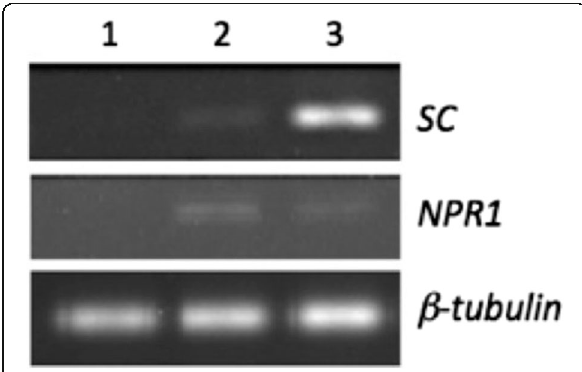
Fig. 3 NPR1 and Sesquiterpene cyclase genes induced in root inoculated plantlets of Capsicum annuum L . Genes level induction assessed by semi-quantitative RT-PCR. Assays with mixed total RNA from root and leaves of mirasol cultivar pepper plantlets in root inoculated with B. velezensis 2A-2B strain, at 12 hs post- inoculation. Lane 1, control plant not inoculated (mock); lane 2, plant in root inoculated with 2A-2B strain; lane 3, a B. velezensis strain inducer of SC gene in chili pepper. SC , sesquiterpene cyclase; NPR1 , nonexpresser of PR